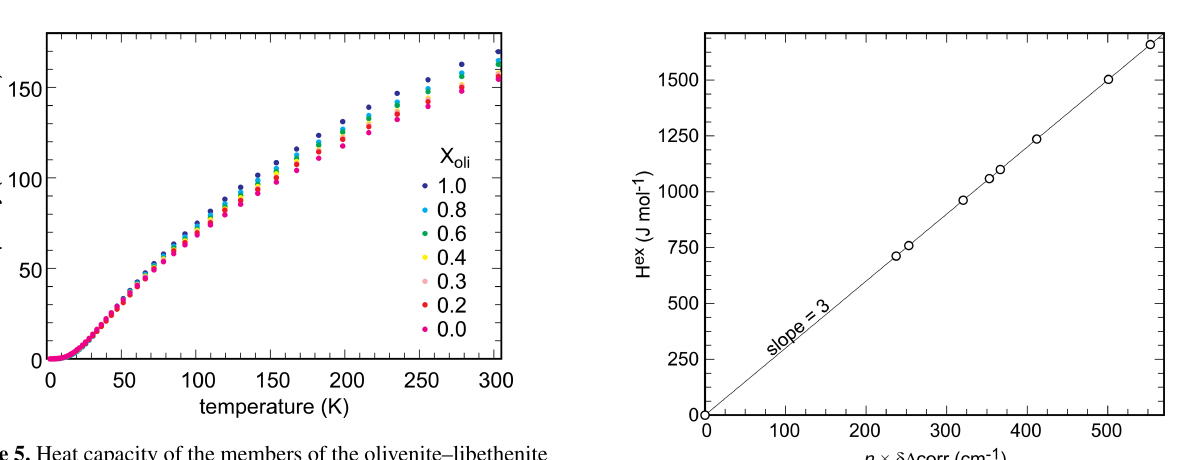
Figure 5. Heat capacity of the members of the olivenite–libethenite solid solution.